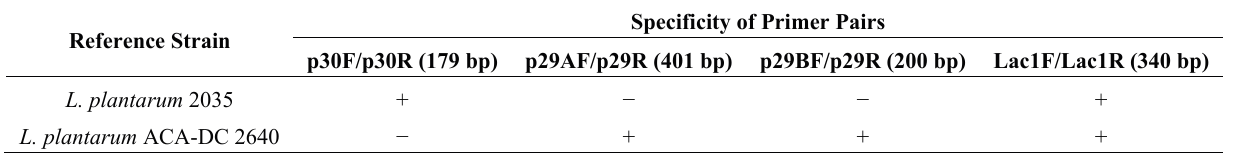
Figure 2. Nucleotide sequences of RAPD amplicons. ( A ) Nucleotide sequences of RAPD amplicons specific to L. plantarum 2035. Arrows represent forward primer p30F and reverse primer p30R and the underlined sequence belongs to the oligo decamer primer RAPD-30; ( Β ) Nucleotide sequences of RAPD amplicons specific to L. plantarum ACA-DC 2640. Arrows represent forward primer p29AF and reverse primer p29R and the underlined sequence belongs to the oligodecamer primer RAPD-29. The sequence of the forward primer p29BF is in bold italics. Table 1. Specificity of primer pairs for Multiplex PCR on L. plantarum 2035 and L. plantarum ACA-DC 2640. The expected size of PCR products is